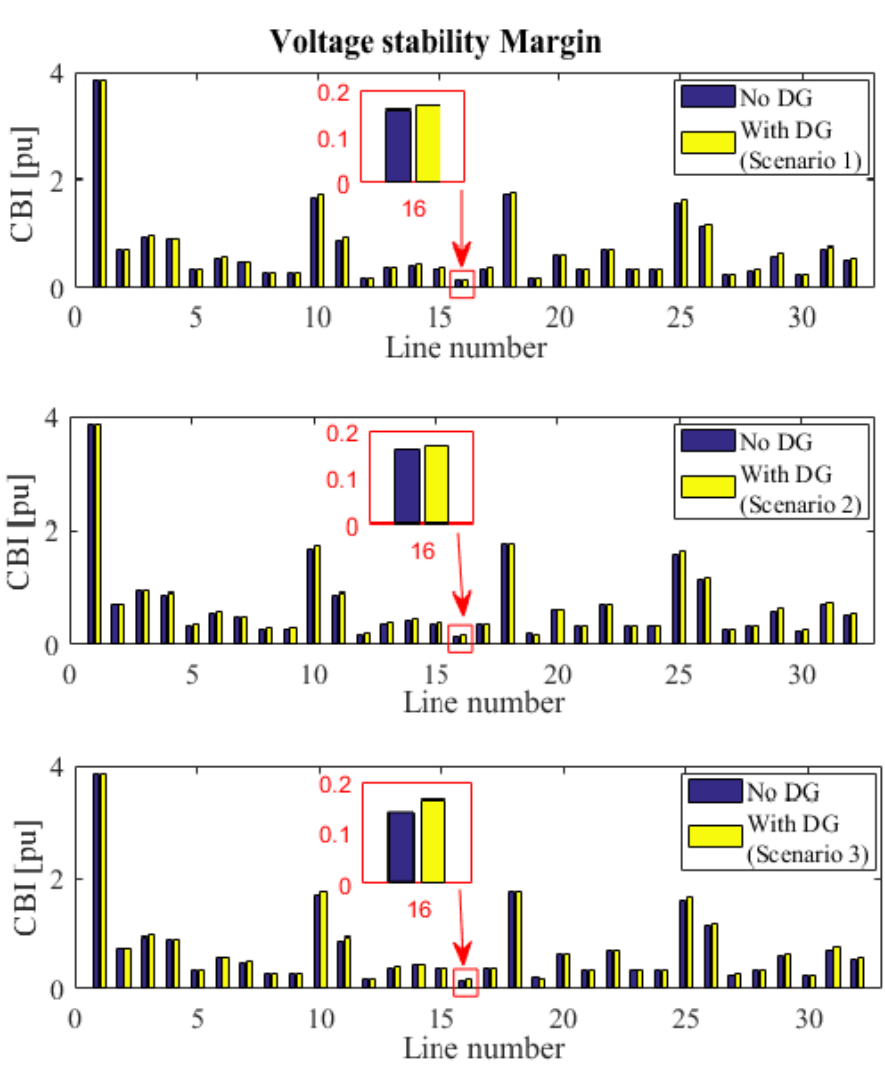
Figure 12. Voltage stability margin without and with